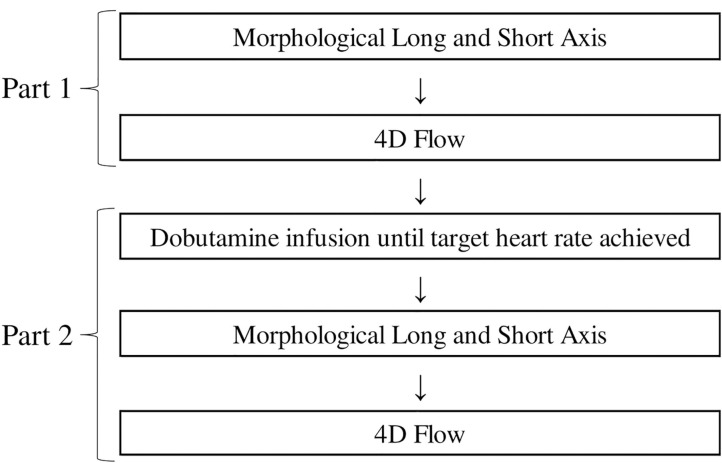
The CMR protocol. Part 1 is performed at rest and Part 2 during dobutamine infusion.